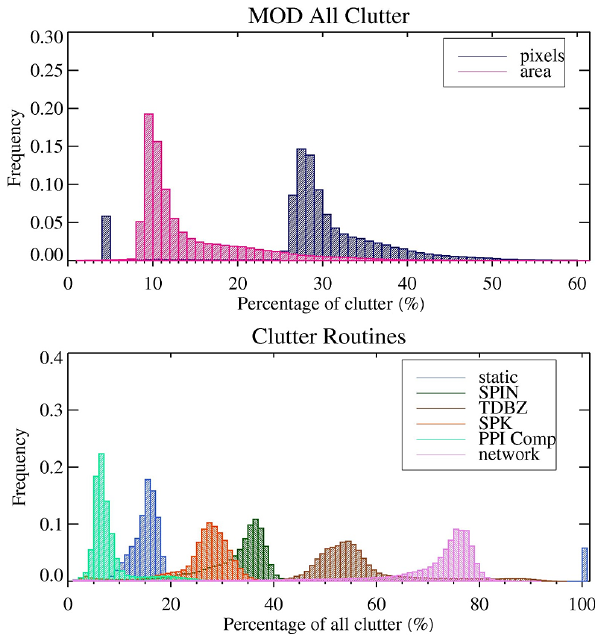
Figure 4. Distribution of clutter for the period from July to Octo- ber 2013. (a) Histogram of the percentage of all clutter range gates (blue) and the clutter area (magenta). (b) Clutter detected by each algorithm (static clutter map in blue, SPIN filter in green, TDBZ fil- ter in brown, spikes and ring algorithm in orange, time-resolution- based algorithm in blue-green and network-based algorithm in vio- let) in percentage of all clutter range